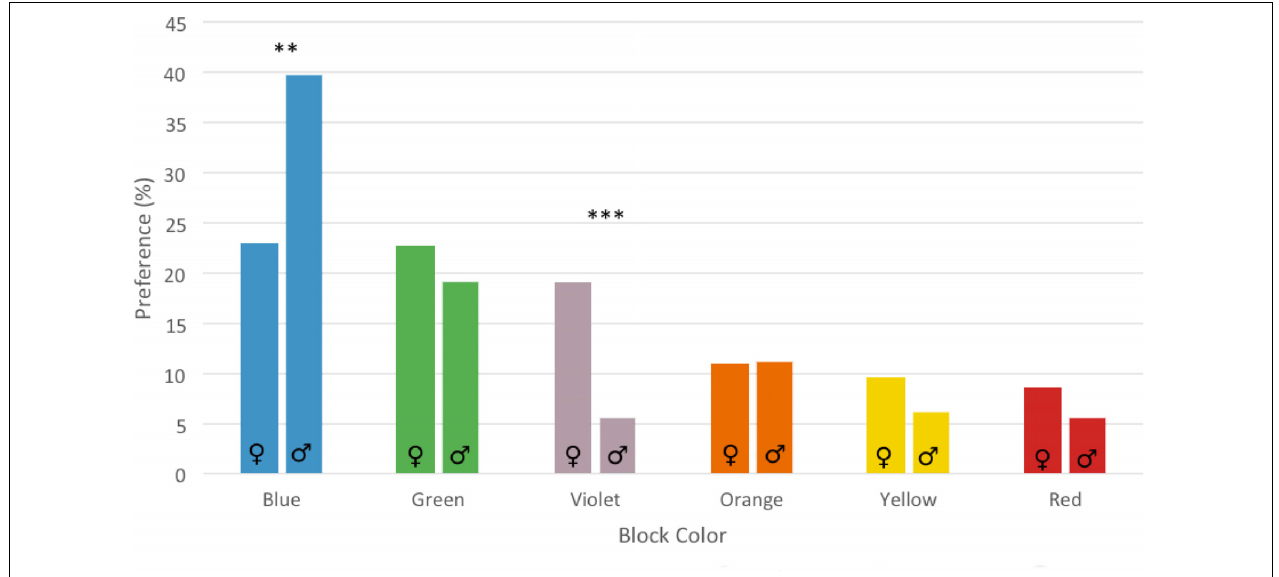
FIGURE 5 | Interior color preference for the six buildings in male and female participants. Asterisks show the significance level of the gender difference test. ∗∗ p < 0.01, ∗∗∗ p < 0.001.